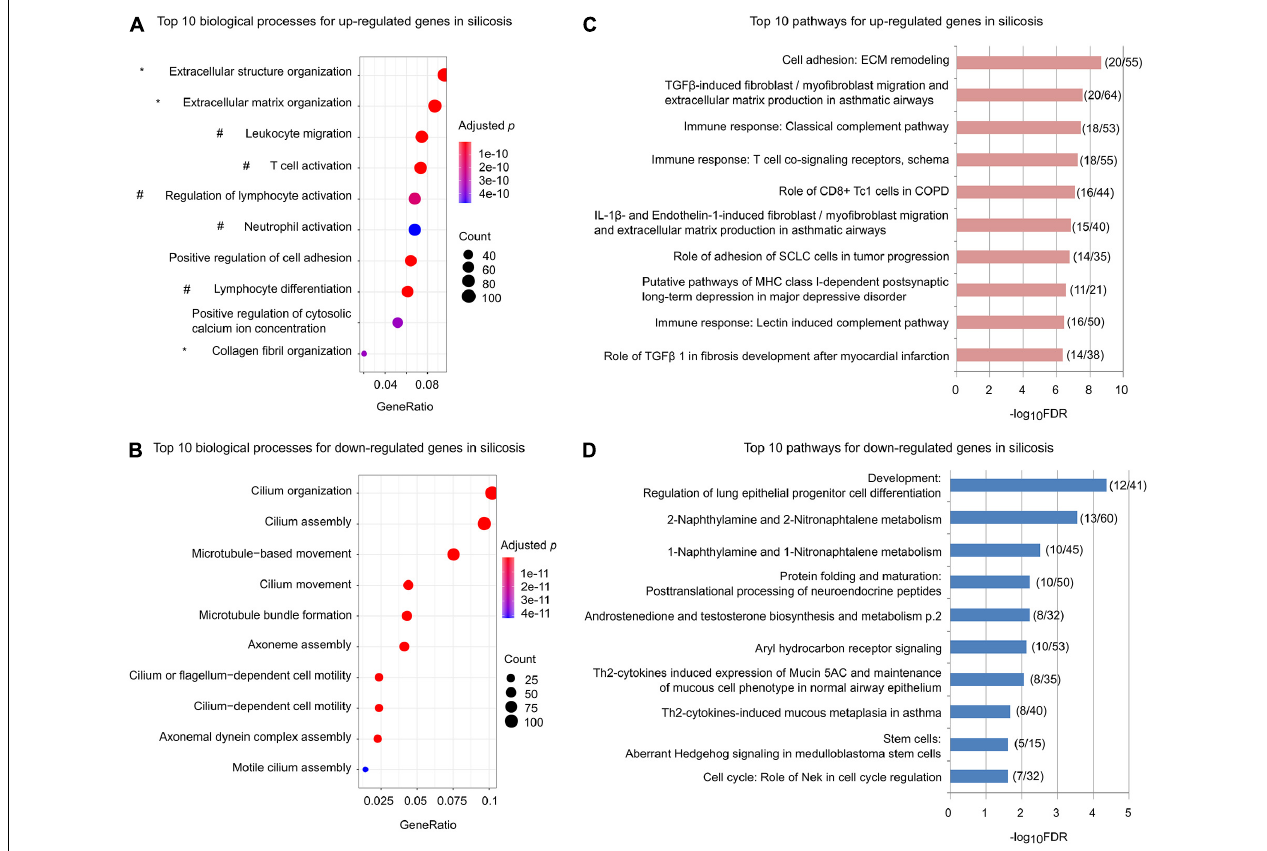
FIGURE 2 | Functional enrichments for the significantly altered genes in silicosis lungs. (A) The top 10 biological processes for up-regulated genes. Processes related to ECM remodeling are indicated with *, while those related to immune related processes are indicated with #. The size of dots reflects the gene counts for each process. Dot color reflects adjusted p -values, where the most significant result is red. (B) The top 10 biological processes for down-regulated genes. (C) The top 10 significantly enriched pathways for up-regulated genes. The x-axis indicates the value of –log 10 FDR for each pathway. The ratios of gene count to the total genes for each pathway are shown in parentheses. (D) The top 10 significantly enriched pathways for the down-regulated